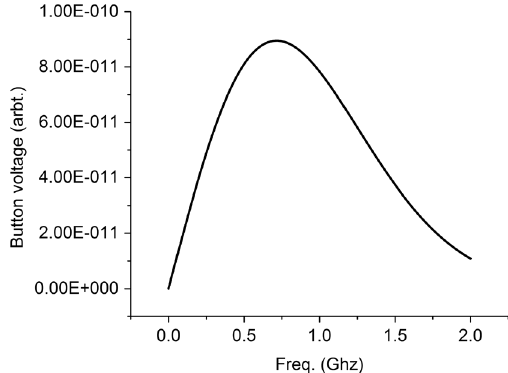
FIG. 15. Fourier transform of the voltage signal induced at the button electrode of the IDBPI obtained through simulation with particle beam of rms length 60 mm.